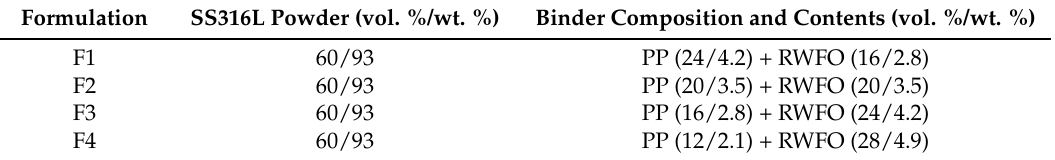
Table 4. Components and contents used for 60% volumetric powder loading (93 wt. %) of feedstocks. Formulation